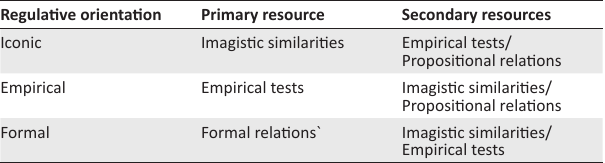
TABLE 1: Summary of analytical terms and their relations. Regulative orientation Primary